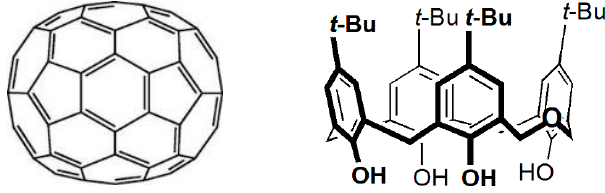
Figure 1. Structures of fullerene C 70 and of p - tert -butyldihomooxacalix[4]arene.